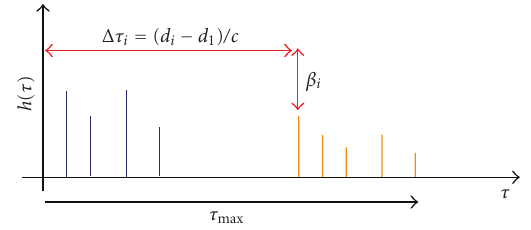
Figure 2: SFN with unequal received